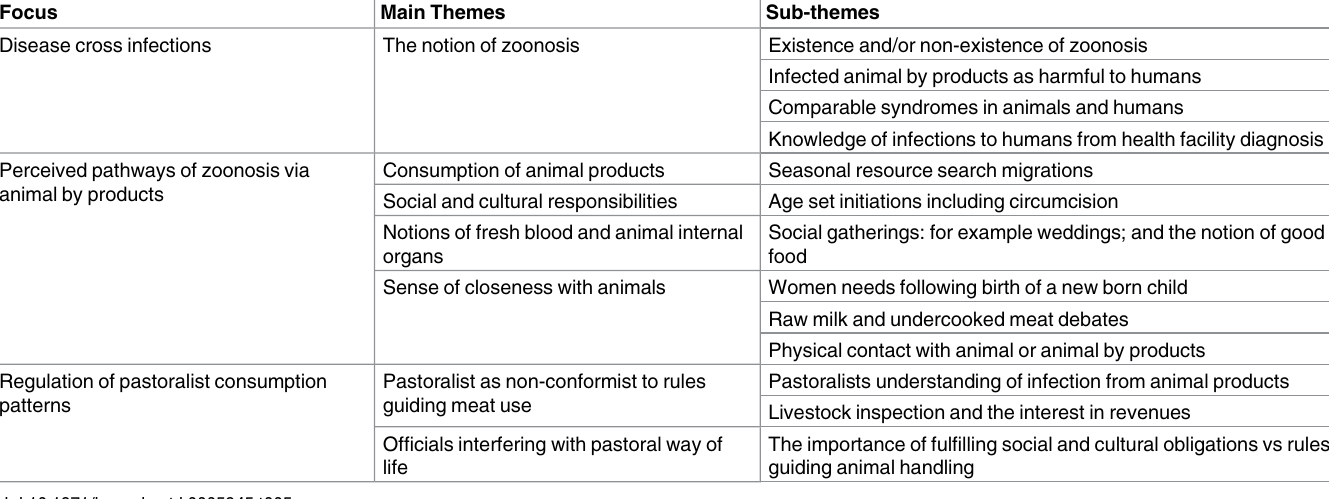
Table 5. Main thematic analysis results